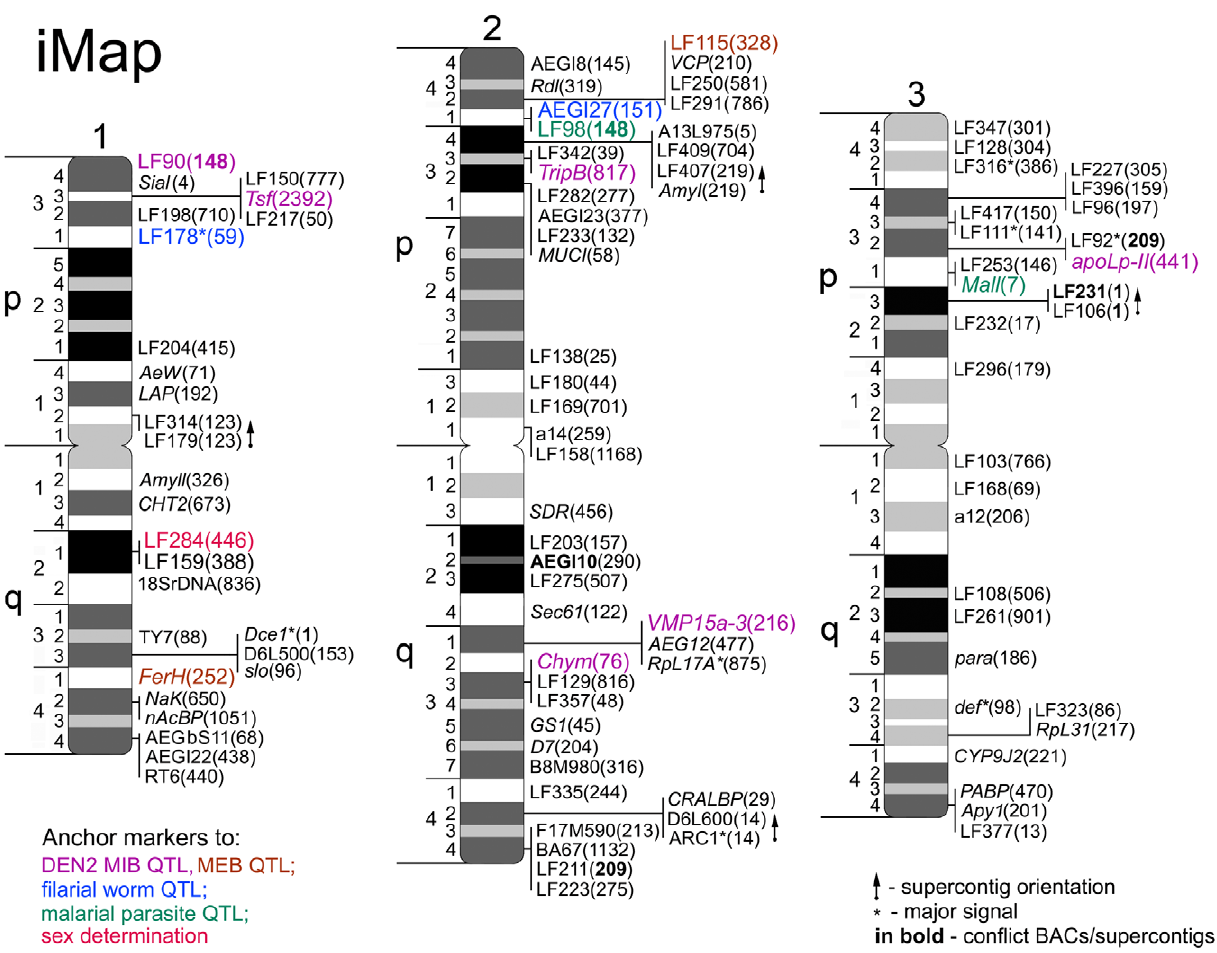
Figure 4. Integrated linkage, chromosome, and genome map–iMap of Ae.aegypti . Chromosome divisions and subdivisions are indicated on the left sides of the idiograms. The positions of genetic markers are shown on the right sides of the idiograms. The numbers of supercontigs in brackets are indicated by last 2–4 digits of supercontig ID. Anchor markers for dengue virus 2 (DEN2) midgut infection barrier (MIB) QTL are in purple; for DEN2 midgut escape barrier (MEB) QTL – in brown; filarial worm QTL - in blue; malaria parasite QTL – in green; for sex determination locus - in red. LF 98 is QTL anchor marker for both filarial worm and malaria parasite pathogens. The orientations of 4 supercontigs are demonstrated by arrows. Major locations of the BAC clones with multiple signals on the chromosomes are indicated by asterisks. Two BAC clones and 3 supercontigs in conflict with previous genetic mapping/genome assembly are in bold.